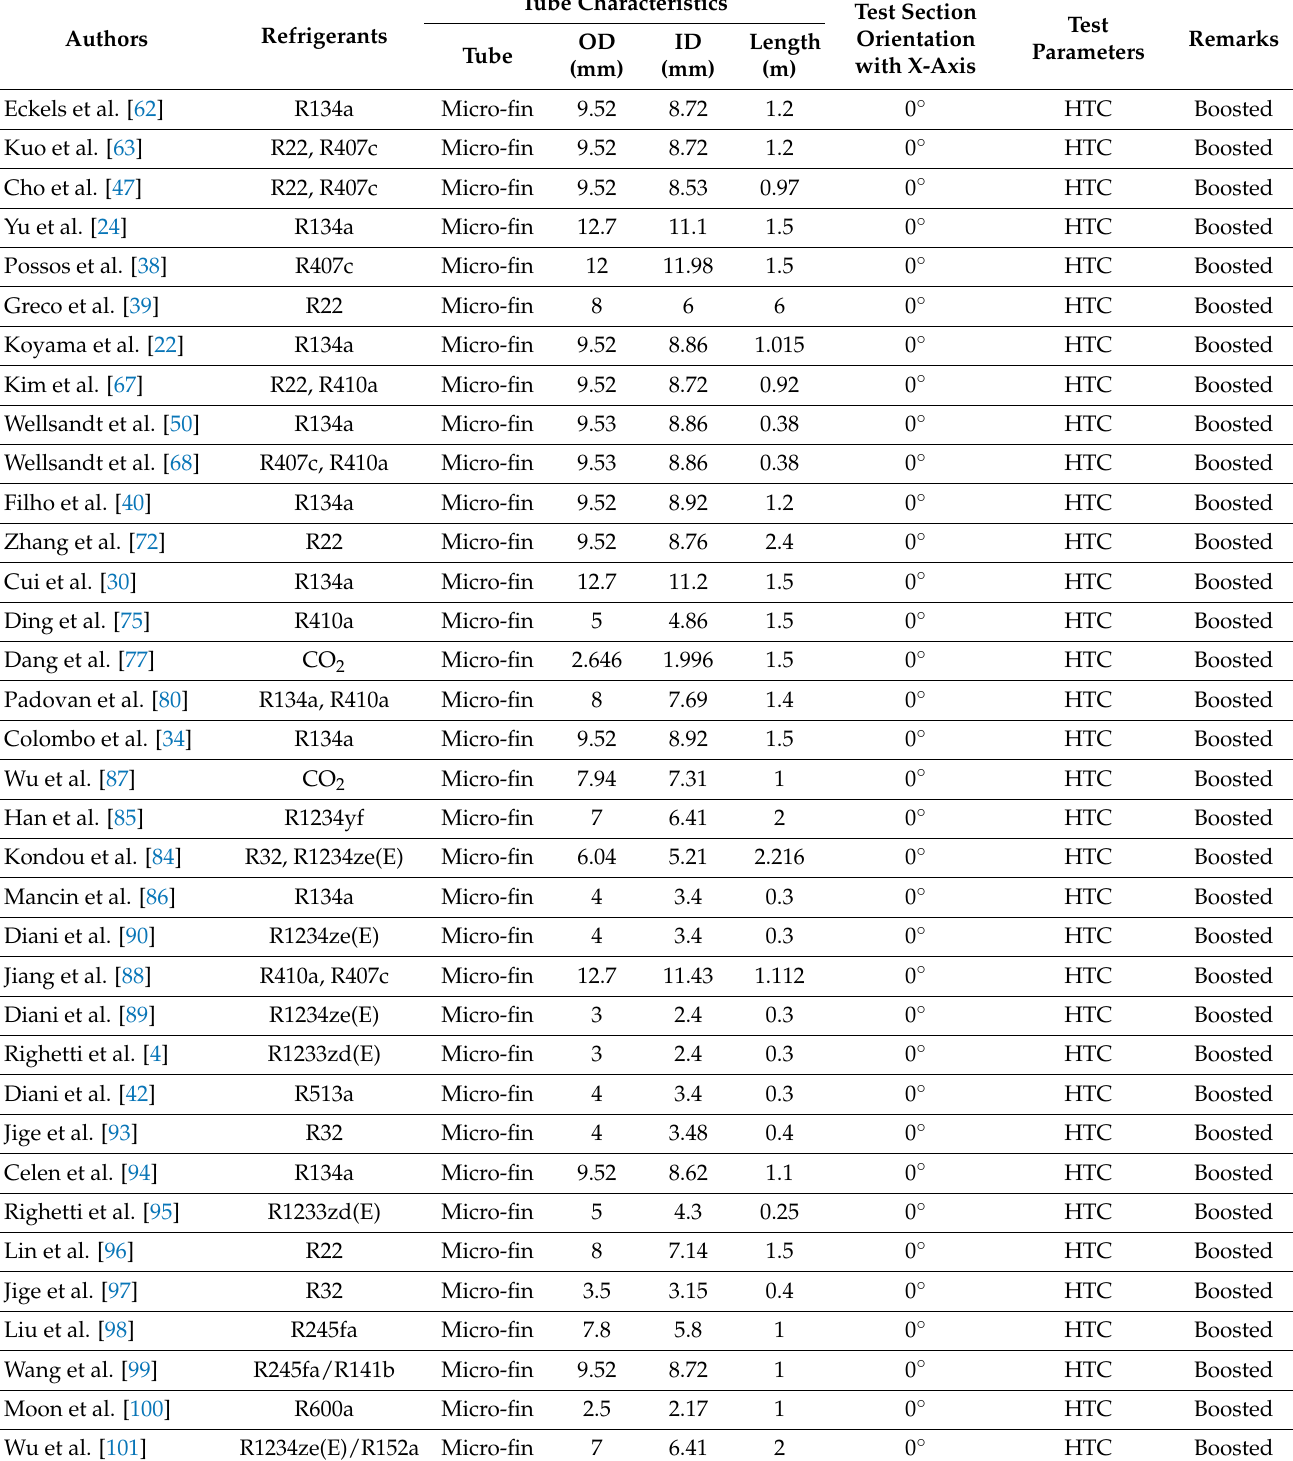
Table 2. Summary of experiments on flow boiling heat transfer of pure and mixed refrigerants in micro-finned